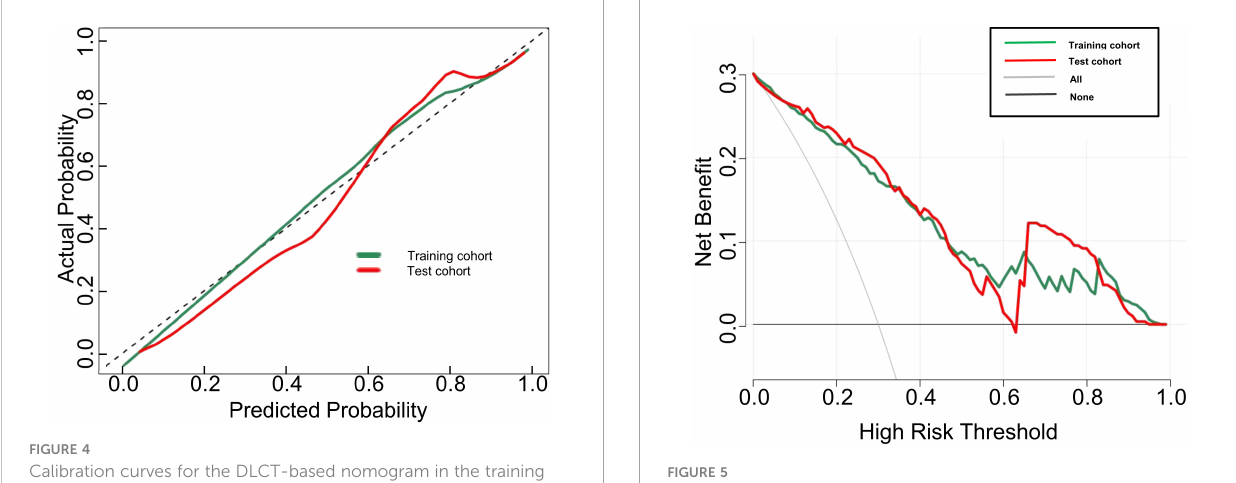
FIGURE 5 Decision curve analysis (DCA) for the DLCT-based nomogram in the training and test cohort. The y-axis measures the net bene fi t and the x-axis represents the threshold probability.